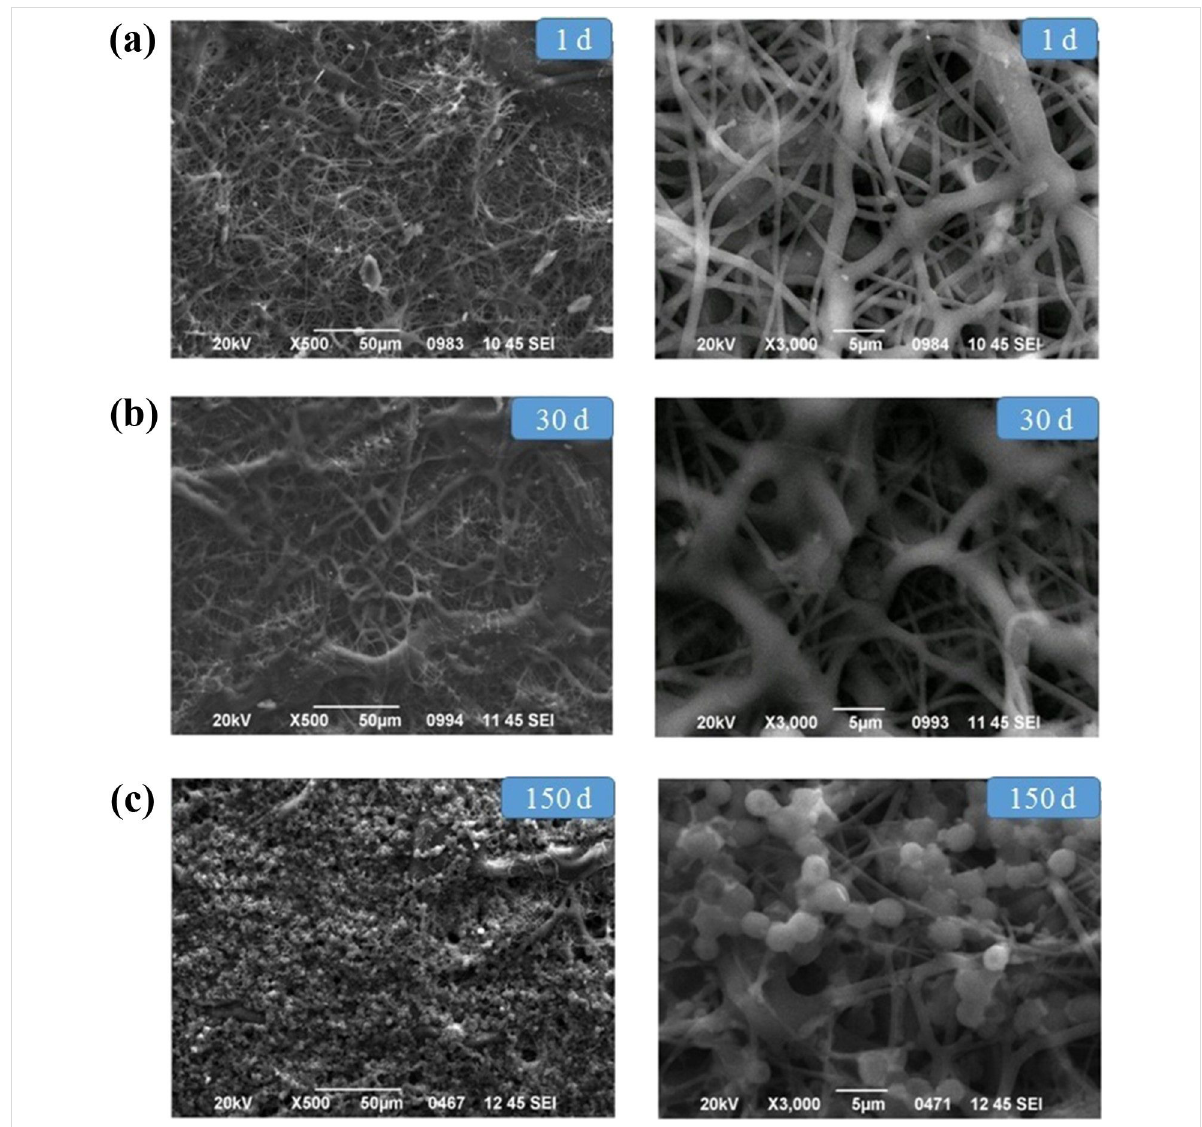
Figure 3: Representative SEM micrographs of CA scaffolds (a) before degradation on the 1st day, (b) after degradation in vitro for 30 days, (c) after degradation in vitro for 150 days. The mean diameters of the CA fibers after day 1 and day 30 were 1040 and 2400 nm, respectively.